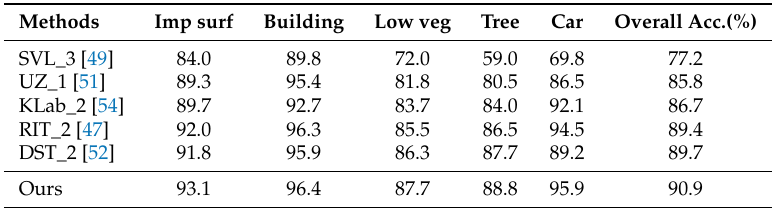
Figure 11. Visual results of benchamark evaluation on the ISPRS Potsdam dataset. Table 4. Benchmark evluation results on ISPRS Potsdam dataset (class F1 score and overall accuracy). Imp surf: impevious surfaces. Low veg: low